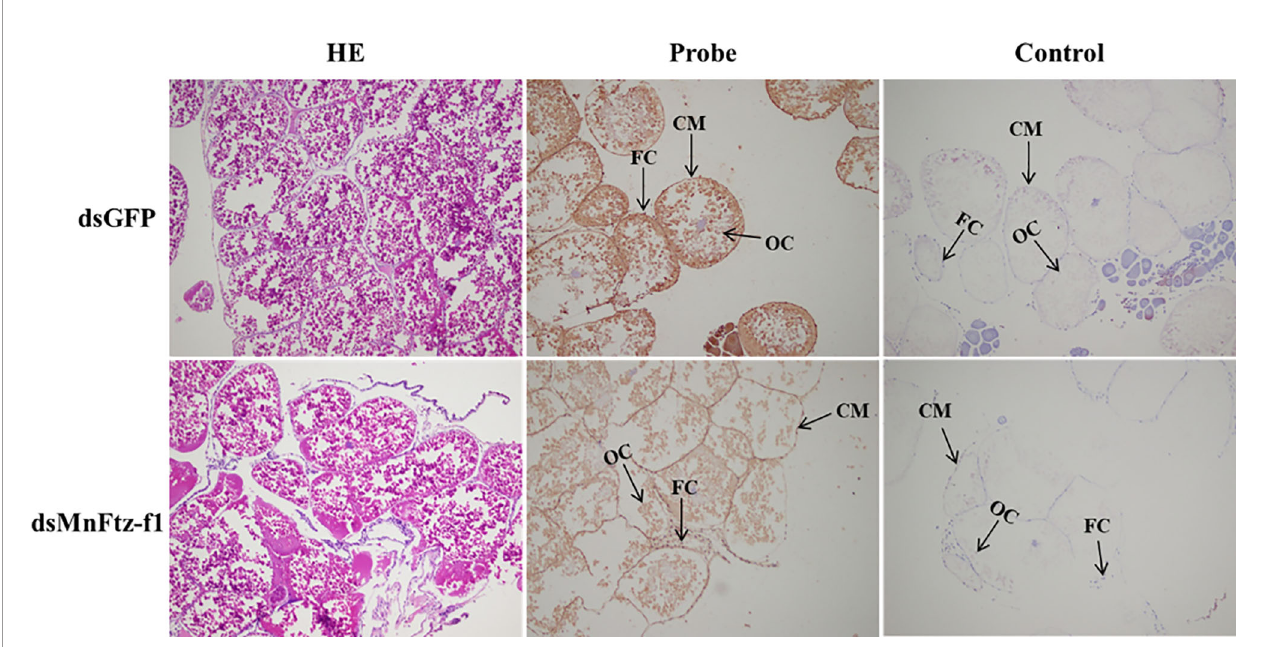
FIGURE 11 | Histological sections of ovarian tissues of the experimental and control groups after RNAi. GFP was used as a control. OC, oocyte; CM, cytoplasmic membrane; FC, follicle cell; scale bar, 20 m m.